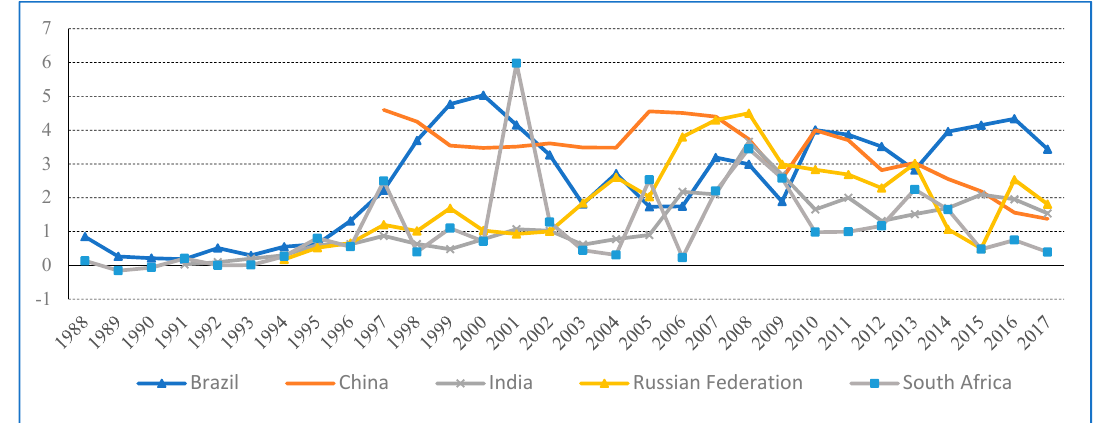
Figure 3. FDI, net inflows (as % of GDP). Source: Own elaboration based on World Development Indicators (World Bank).